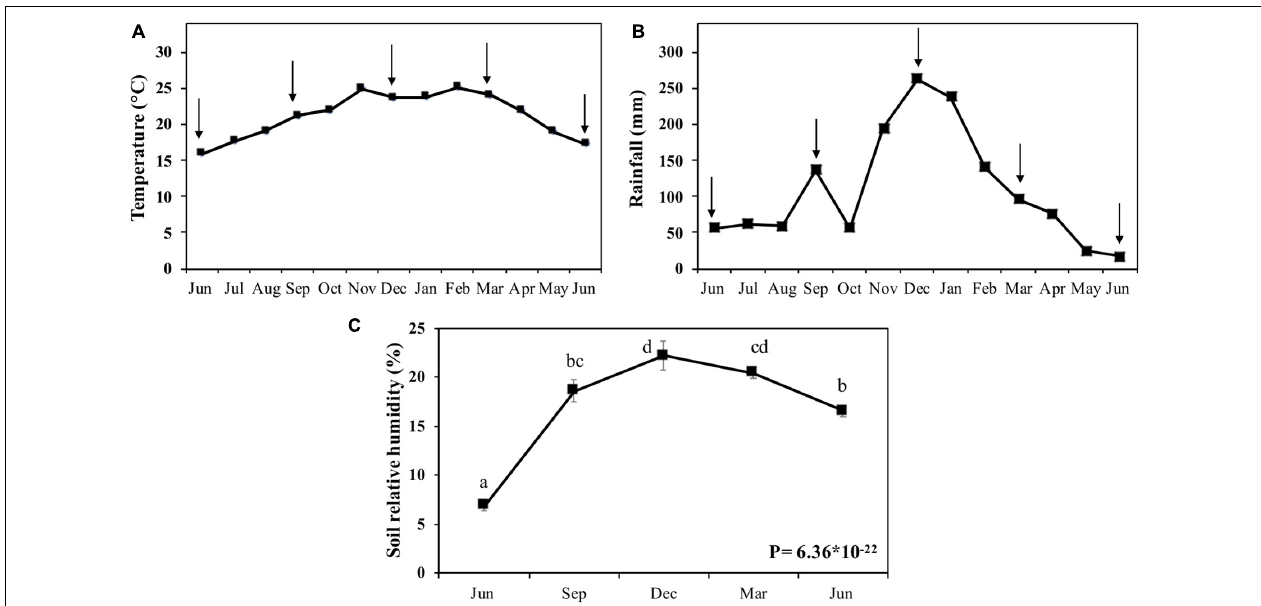
FIGURE 2 | Climatic conditions and soil humidity in the field. (A) Average monthly temperature ( ◦ C). (B) Monthly rainfall (mm). (C) Soil relative humidity (%). (A,B) were generated from the data of Posto Agrometereológico do Departamento de Ciências Exatas da Escola Superior de Agricultura “Luiz de Queiroz,”